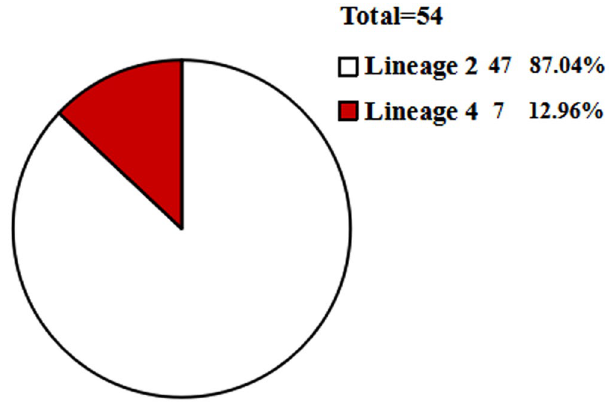
Figure 2. The distribution of M. tuberculosis strains lineage in the Gansu. The Lineage 2 accounts for 87.04% and the Lineage 4 accounts for Risk Factors.